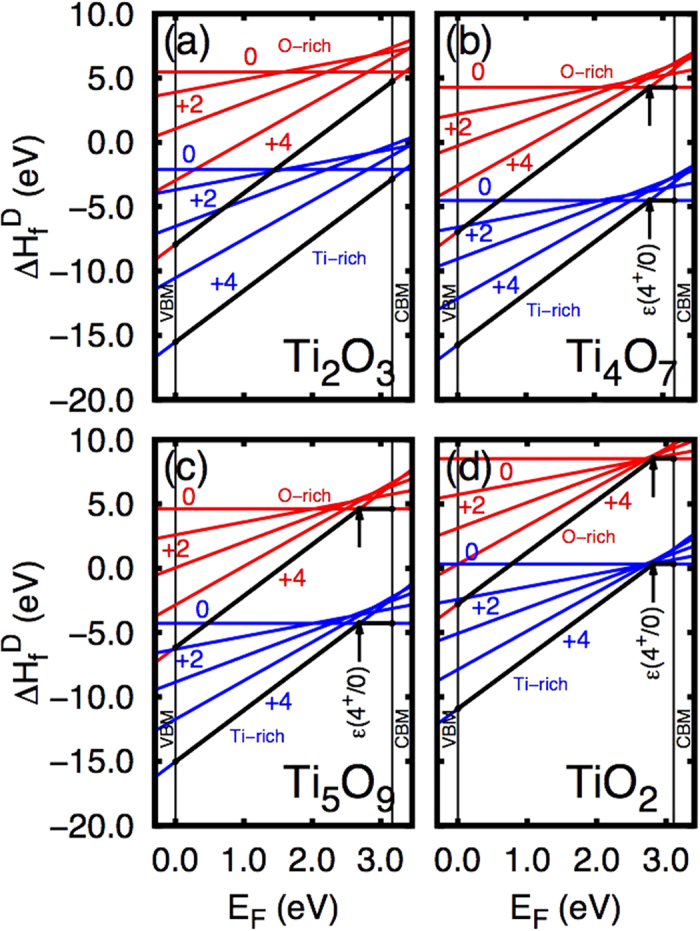
Formation enthalpies for (a) Ti2O3, (b) Ti4O7, (c) Ti5O9, (d) and Tii point defect in rutile TiO2. The Tii formation energies shown on (d) are from ref. 16. The thick black lines emphasize the lowest energy charge state for each occupation for the entire band gap span, and the transitions from +4 charge state to the neutral charge state in Ti4O7, Ti5O9, and TiO2 are also featured as ε(4+/0).